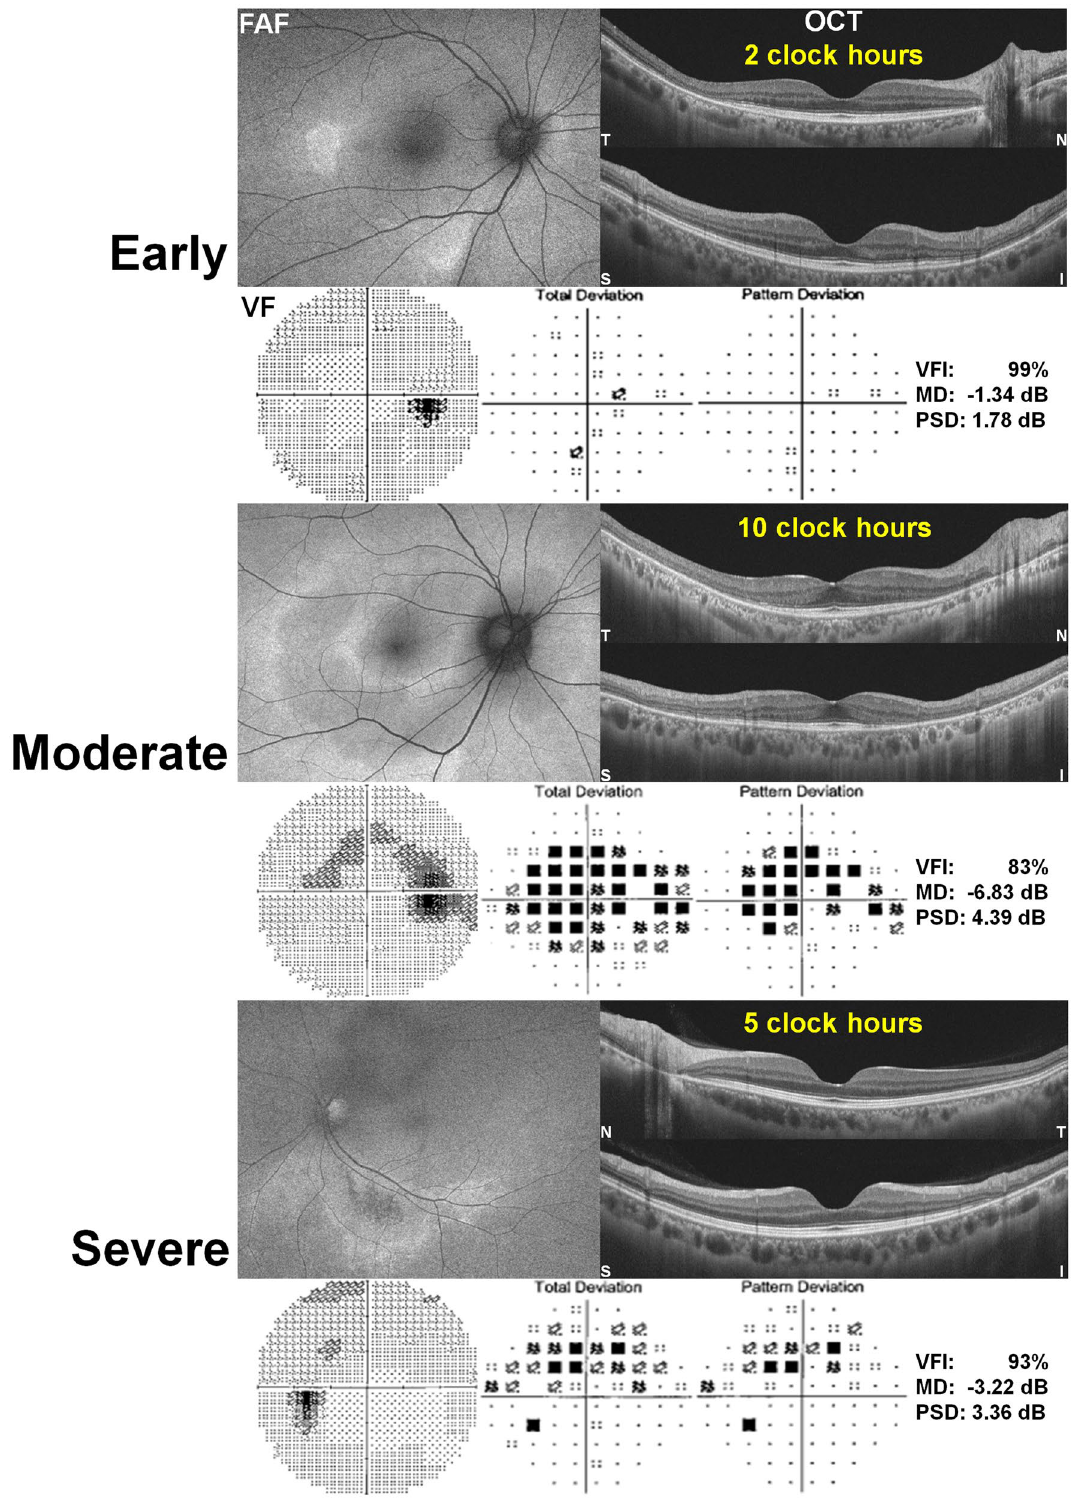
Figure 5. Photographic examples of fundus autofluorescence (FAF), optical coherence tomography (OCT), and automated visual field (VF) results including visual field index (VFI), mean deviation (MD), and pattern standard deviation (PSD) in eyes with early, moderate, and severe retinopathy. The extent of photoreceptor damage on OCT (indicated in yellow) showed 2, 10, and 5 clock-hour extents for the respective cases of early, moderate, and severe retinopathy. The moderate retinopathy case showed larger clock-hour involvement of retinal damage than the severe one, also showing worse perimetric function, represented by worse VFI, MD, and PSD. T = temporal; N = nasal; S = superior; I =